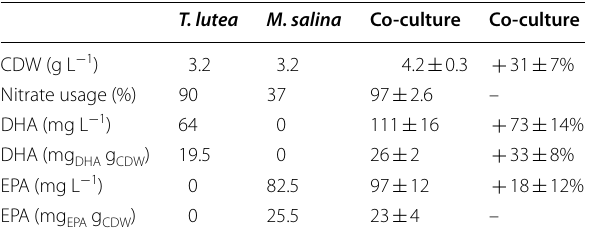
Table 1 Comparison of photoautotrophic monocultures of the DHA‑producing microalgae T. lutea and the EPA‑producing M. salina with a co‑cultivation of the two microalgae at a harvest time after 8 days (consumption of initially supplied nitrate in co‑culture) relative to the illuminated surface of the flat‑plate gas‑lift photobioreactors T. lutea